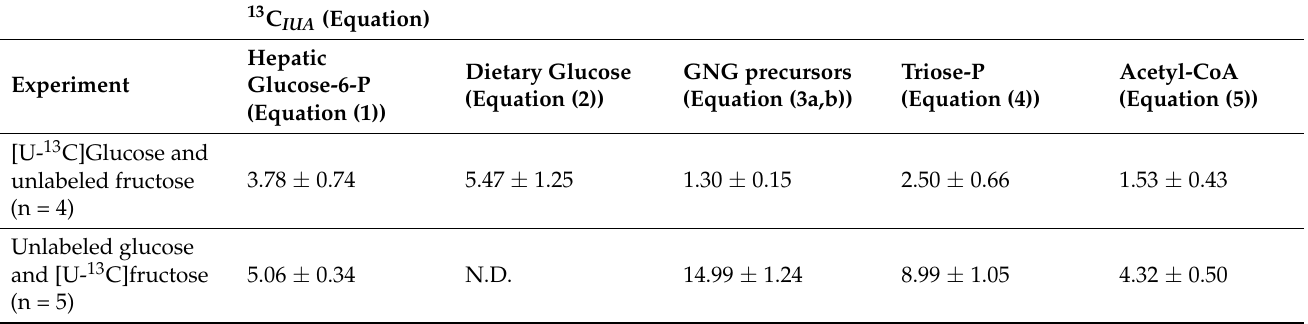
Table 1. Fractional enrichments (%) of 13 C-isotopomers that generate or are associated with lipogenic [U- 13 C]acetyl-CoA ( 13 C IUA ) for selected hepatic metabolite pools for a group of four mice provided with 2 H 2 O and [U- 13 C]glucose tracers, and a group of five mice provided with 2 H 2 O and